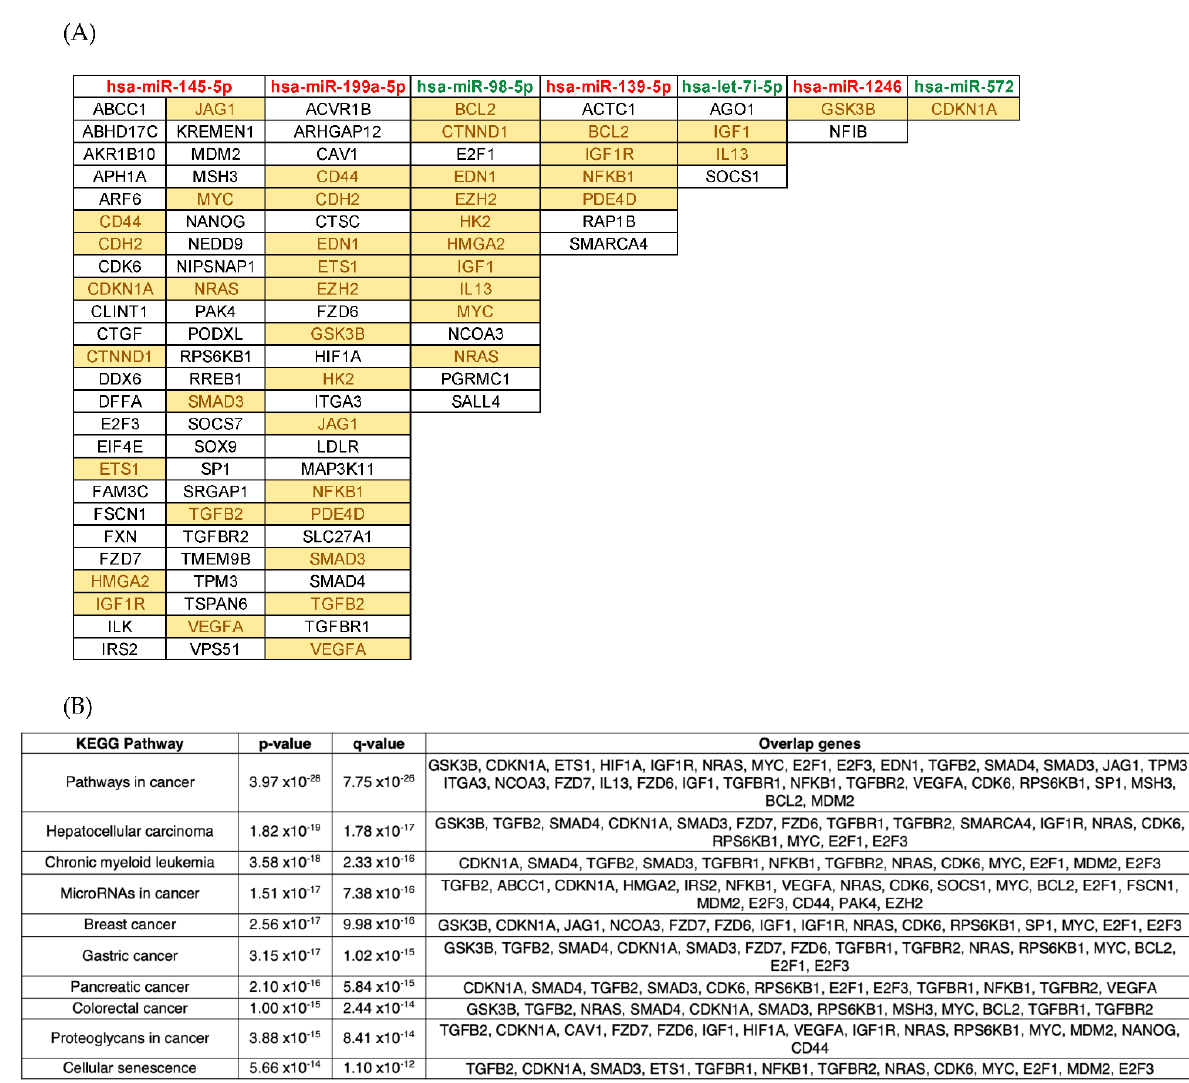
adjusted p -value (adjusted for multiple testing with the Benjamini – Hochberg procedure) and x-axis as the log 2 -fold change. The vertical lines represent a threshold of |log 2 -fold change| > 1.5, either upregulated (right side) or downregu- lated (left side), while the horizontal lines represent an FDR < 0.05. Each colored point represents an individual probe in severe versus asymptomatic comparison (D: green: upregulated, A: orange: downregulated), and in severe versus mild comparison (C: purple: upregulated, B: grey: downregulated). ( C ) Hierarchical clustering of Log 2 normalized expression values of the differentially expressed miRNAs and snoRNAs in severe versus asymptomatic comparison (n = 25), and in severe versus mild (n =